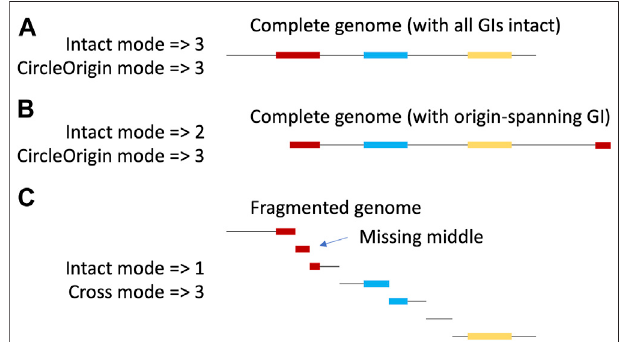
FIGURE 1 | New TIGER modes. The same circular chromosome with 3 (colored) GIs is shown with a complete (A,B) or fragmented assembly (C) . With complete assembly, if the origin of the linearized sequence of the circle is randomly chosen, it will occasionally fall within a GI, splitting the GI (B) . Yields are shown for the various TIGER modes. The original mode can only fi nd intact GIs on a single scaffold, while the new modes, CircleOrigin (applied to complete assemblies) and Cross (applied to fragmented assemblies), can additionally fi nd the split islands. Because TIGER focuses on GI- fl anking sequences, the Cross-mode call for a multiply split GI (red in panel C) will only include the terminal fragments and exclude middle GI